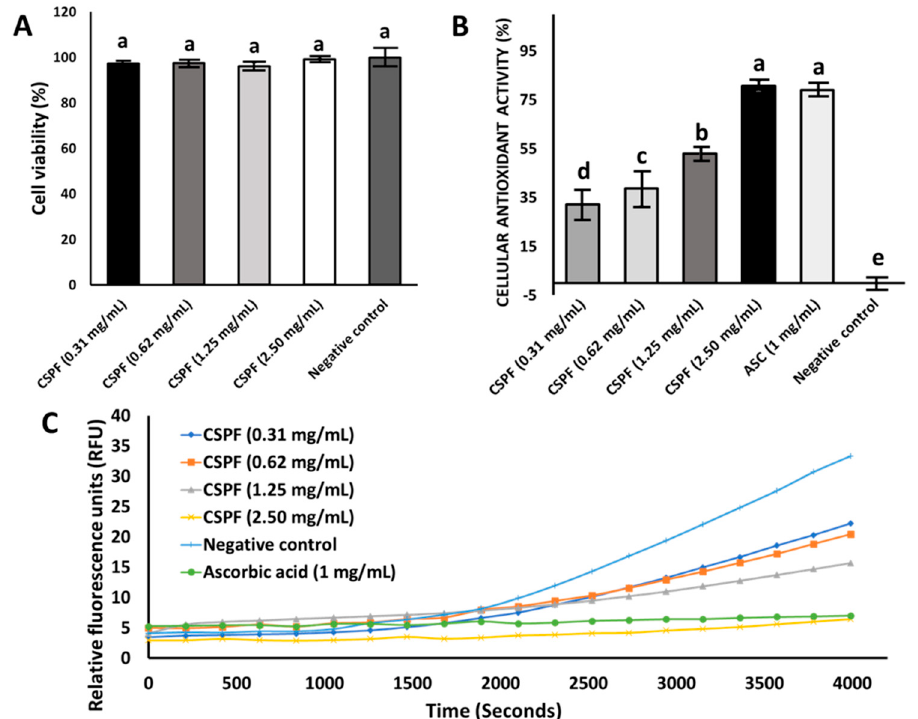
Figure 1. ( A ) Cell viability (%): MTT assay over canary seed peptide fraction (CSPF) at different protein concentrations, ( B ) intracellular antioxidant activity (%) of CSPF and ascorbic acid (ASC), and ( C ) inhibition of peroxyl-radical-induced DCFH oxidation to DCF by CSPF and ASC. Negative control: untreated cells. Bars and lines represent mean values of triplicate determinations ± standard deviation. Different letters (a–e) indicate statistical differences ( p < 0.05) between samples.